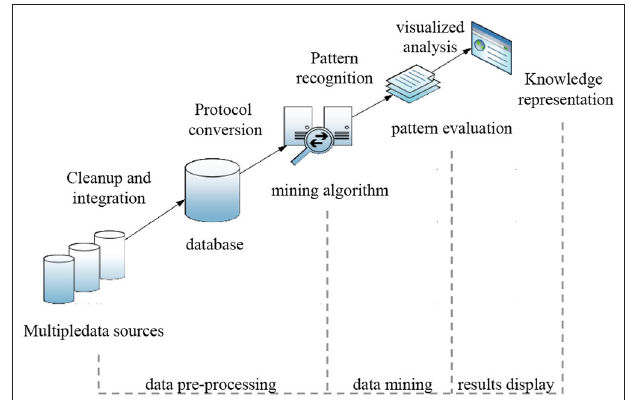
FIGURE 1 | Data-mining